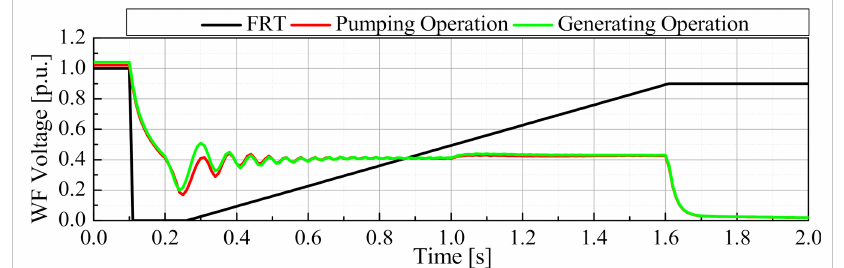
Figure 13. Responses of wind farm (WF) voltage and fault ride-through (FRT) grid code.